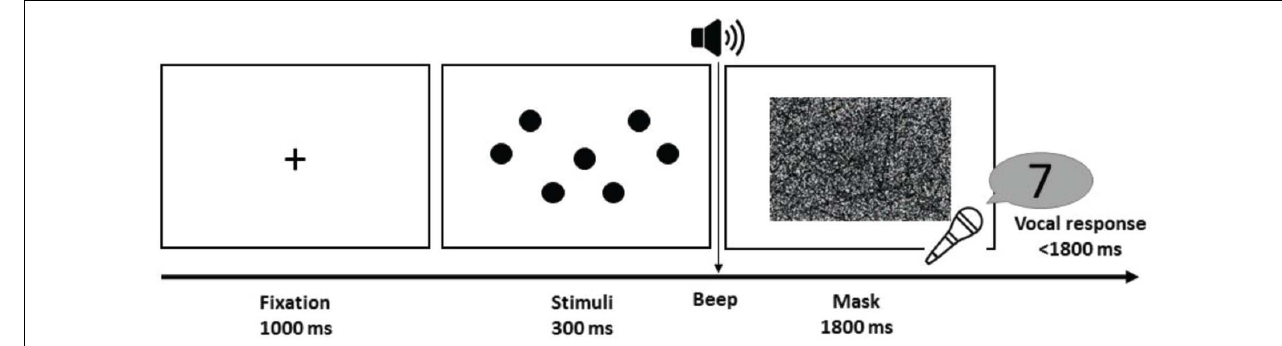
FIGURE 2 | Procedures of the subitizing task. Each trial started with a fixation for 1,000 ms, followed by the stimuli for 300 ms and a visual mask for 1,800 ms. The mask began with a beep, which signaled the participants to verbally respond with a